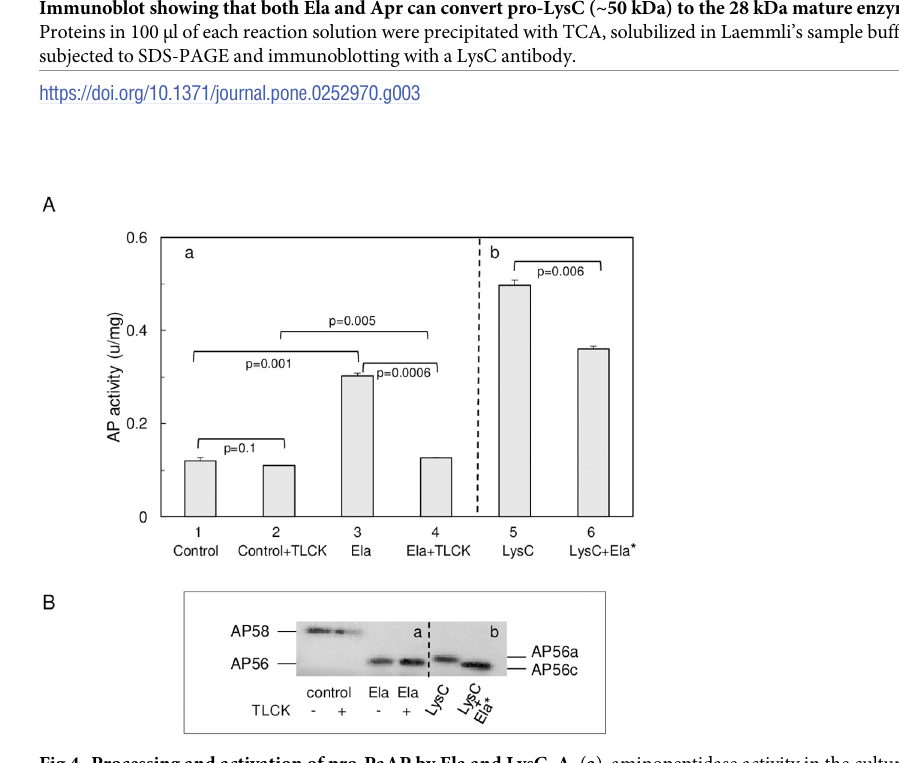
Fig 4. Processing and activation of pro-PaAP by Ela and LysC. A, ( a ), aminopeptidase activity in the culture filtrate of strain FRD1185 (Ela - Apr - LysC + ) after incubation with Ela in the absence (1,3) or presence (2,4) of TLCK. Control, incubation without Ela. ( b ), aminopeptidase activity after incubation with LysC alone (5) and after addition of Ela to a sample removed from this reaction solution and incubation for an additional hour (6; LysC+Ela � ). Ela and LysC activities were blocked at the end of the incubation by adding phosphoramidon and TLCK. � Ela was added after prior incubation with LysC alone. P values below each bar refer to differences between the indicated columns. The differences between the control (1) and combined LysC and Ela (5,6) are significant (p = 0.0007 and 0.009, respectively) and so is the difference between Ela and LysC treatment (3 vs 5); p = 0.003). Aminopeptidase activity ( A ) was determined fluorimetrically with Leu-7-amido-4-methyl coumarin as the substrate. B , Immunoblot revealing distinct migration positions (size) of active PaAP, depending on the activating protease.